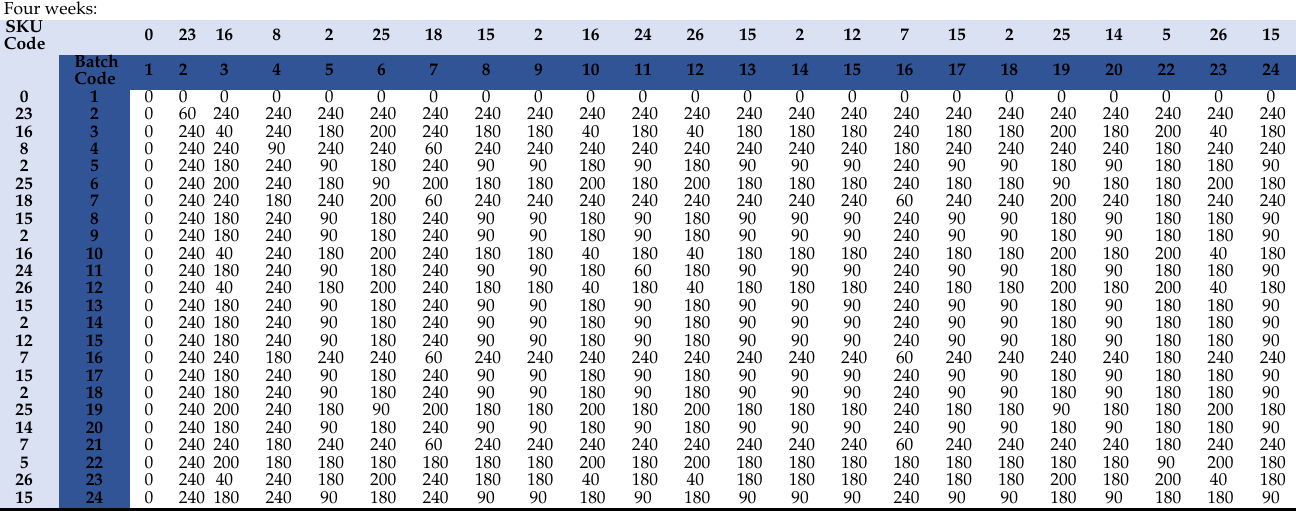
Table 5. Setup time matrix for three weeks, Machine 7, 13